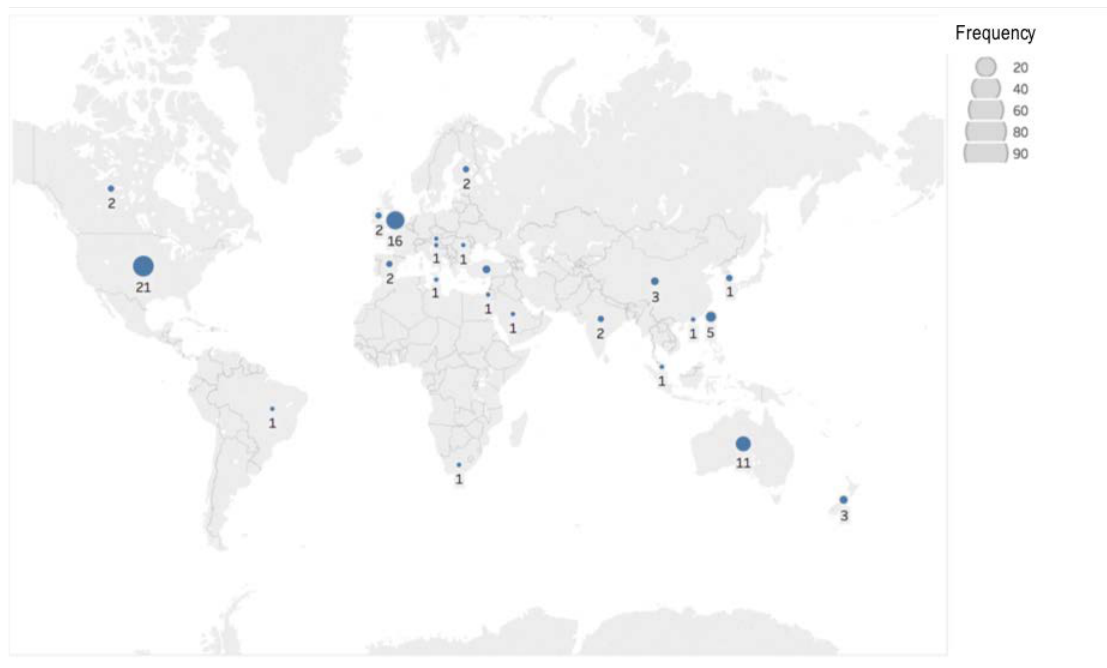
Figure 4. Geographical distribution of documents by